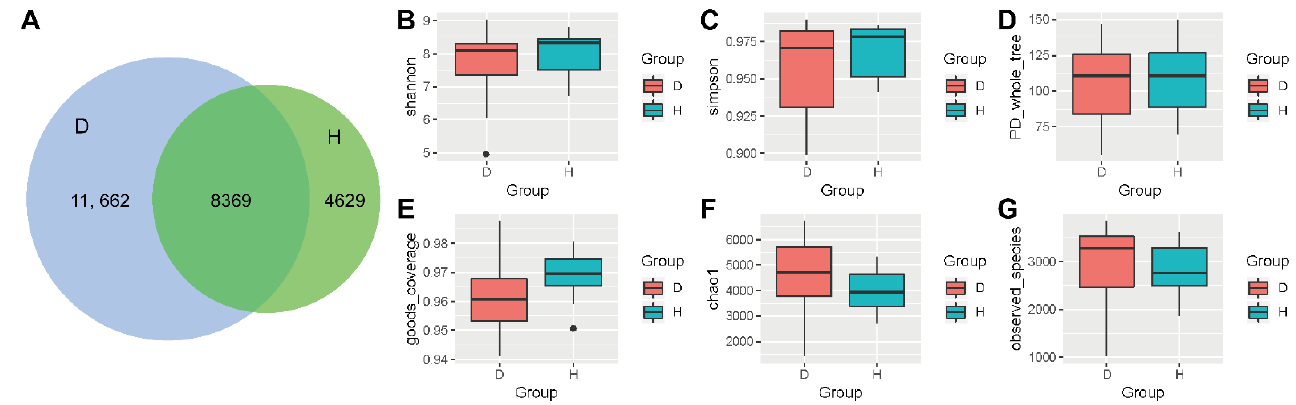
Figure 1. Alpha-diversity indexes between healthy cattle and cattle with respiratory disease. ( A ) OTUs of the whole samples. ( B – G ) Boxplots of alpha-diversity indexes comparing the D group and the H group. ( B ) Shannon diversity index. ( C ) Simpson diversity index. ( D ) phylogenetic diversity (PD_whole_tree). ( E ) goods_coverage. ( F ) Chao 1. ( G ) Observed_species. D: bovines with respiratory disease, H: healthy bovines.